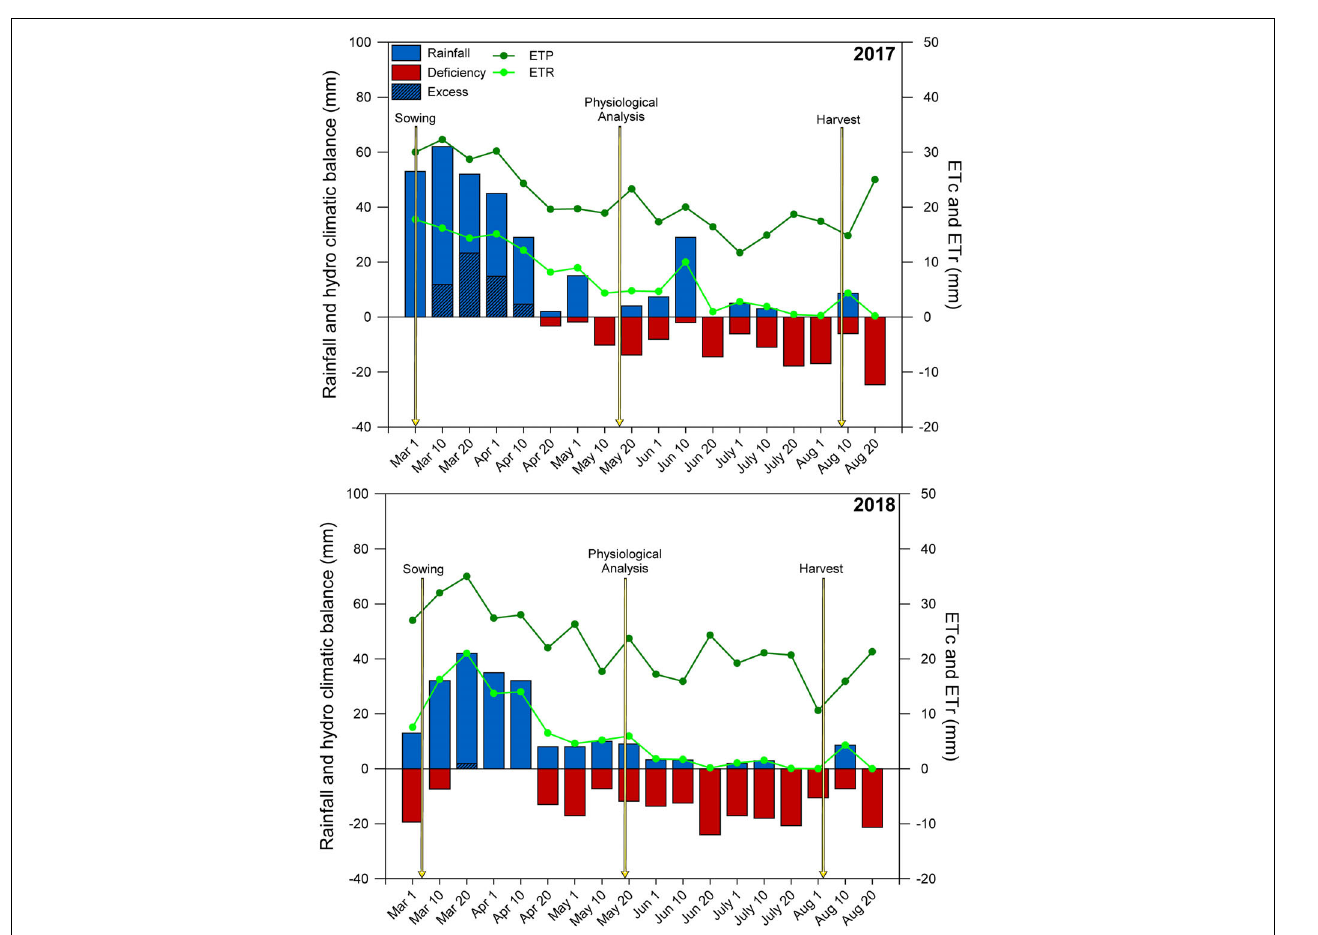
FIGURE 1 | Climatological water balance at Botucatu-SP, Brazil, during the maize crop cycle. ETc, crop evapotranspiration; ETr, real evapotranspiration. The arrows indicate the managing and sampling time.